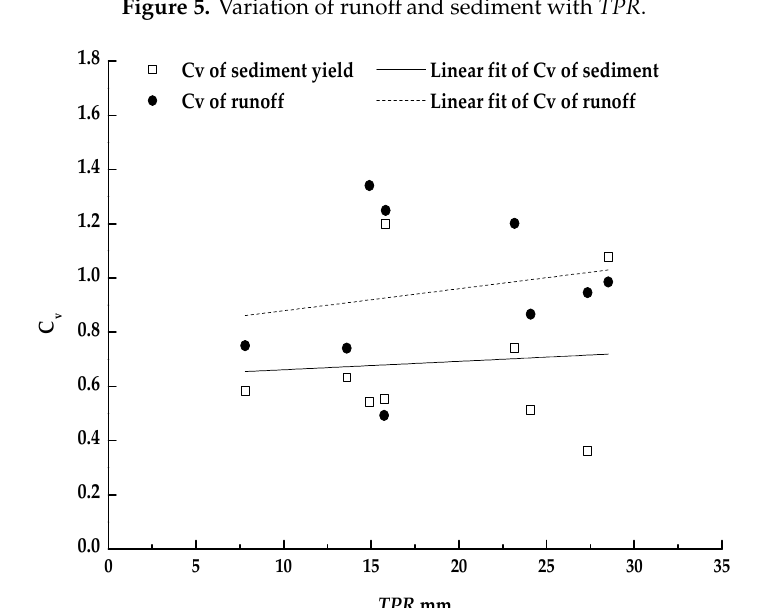
Figure 6. Change in the C v of the annual runoff and sediment yield with the total peak rainfall amount of one rainfall ( TPR ).